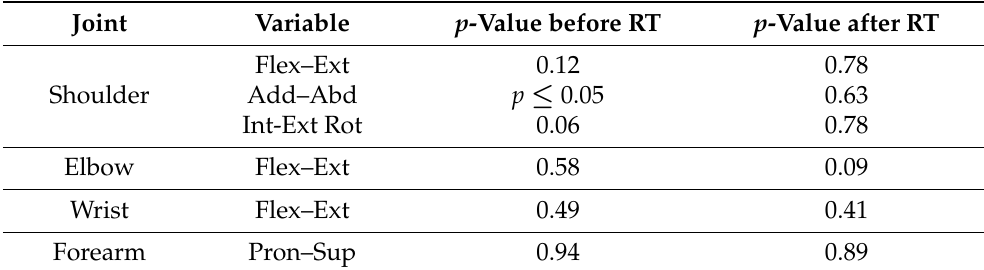
Table 12. RoM Wilcoxon test of the paretic and non-paretic limb in the Apley Scratching Test before and after the rehabilitation therapy.